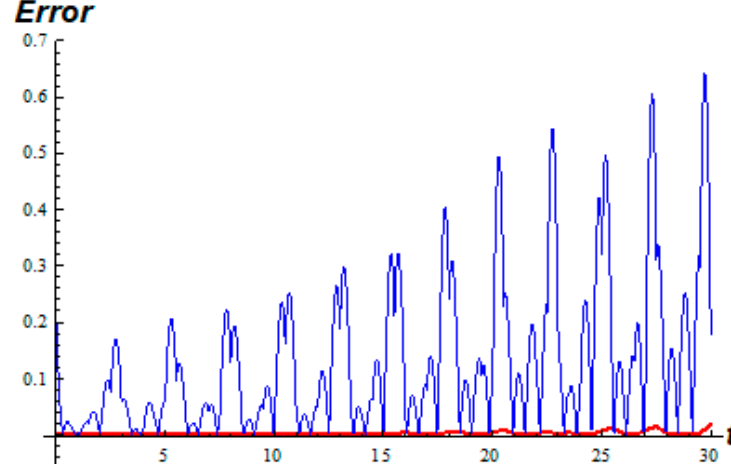
Figure 6. Plots of approximate solution method (red solid line) and RK4 method (blue dashed line) for 0 30 t ≤ ≤ and step-size 0.5 h = .